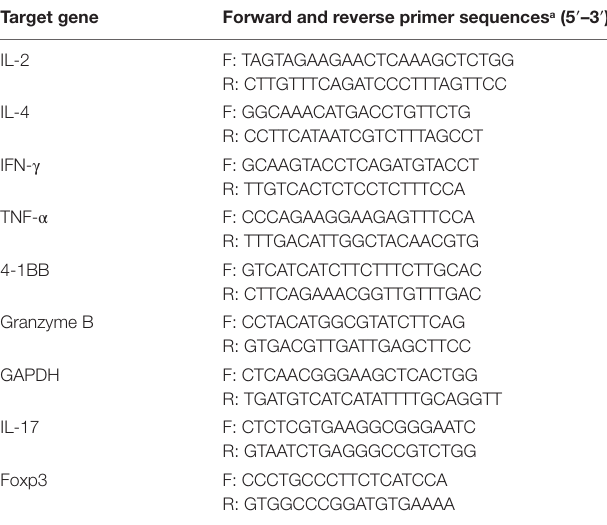
TaBle 2 | Primer pairs used for quantitative real-time PCR. Target